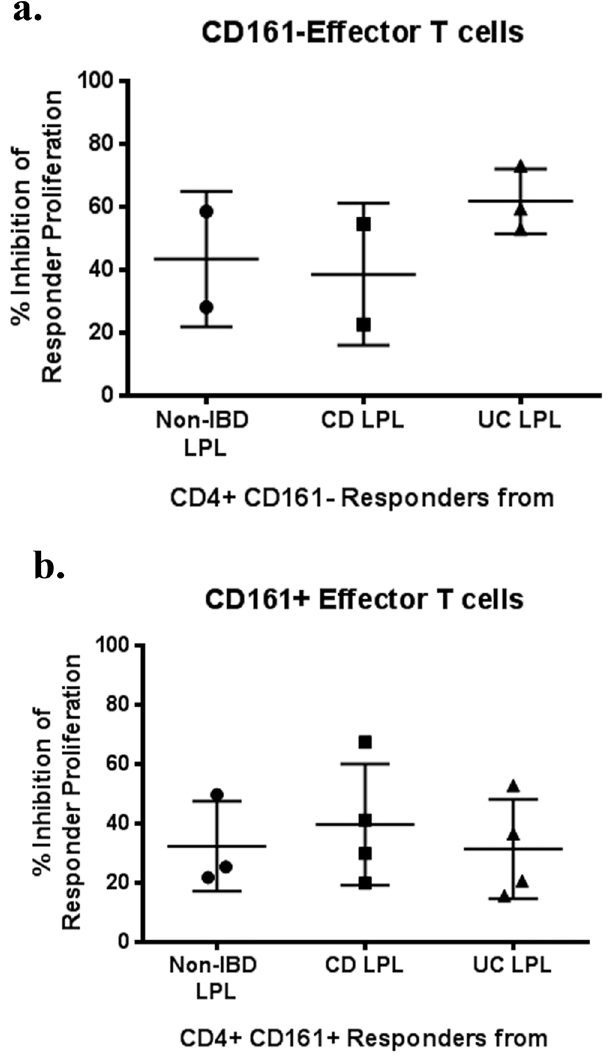
Fig 2. LPL CD4 + effector T cells from IBD patients can be suppressed in vitro by Tregs. CD4 + , CD45RA - LPL T cells homogenized from the surgically resected intestines of patients with or without IBD were sorted into CD161 + and CD161 - subsets, CFSE-labeled, and cultured with or without Tregs sorted from the spleen of a single donor, as in Fig 1, at a 1:2 Treg:effector ratio for 4 days in the presence of soluble anti- CD3 (OKT3). The percent that CFSE dilution by CD4 + LPL from the indicated donors was diminished by the presence of splenic Tregs is shown for CD161 - (a) and CD161 + (b) LPL. CD = Crohn ’ s disease. UC = ulcerative colitis. LPL = lamina propria